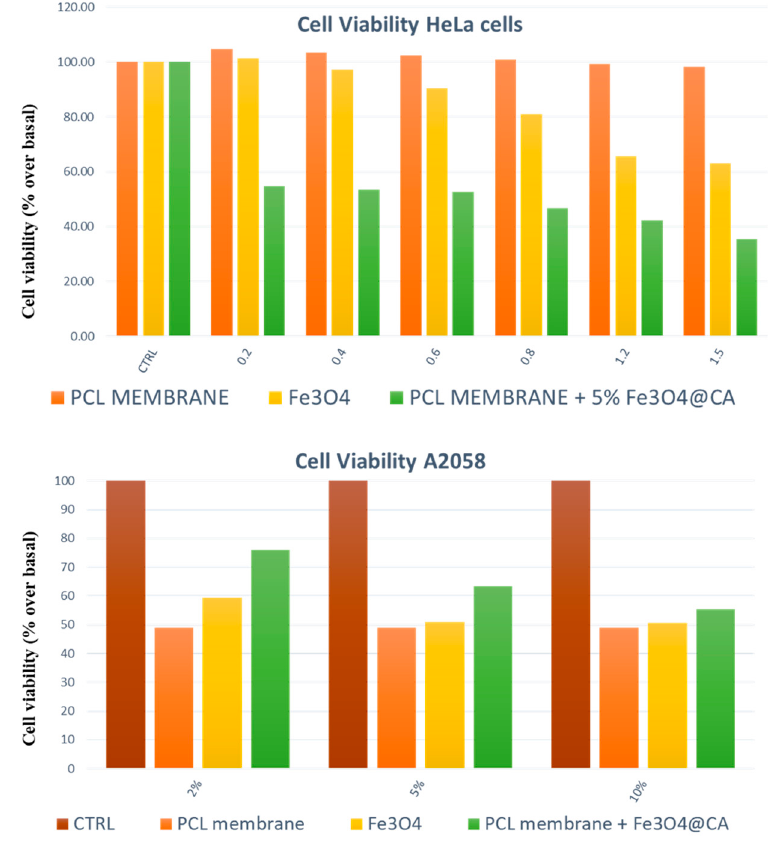
Figure 14. Cells viability for cervix uterine cancer ( up ) and melanoma ( down ) cell lines.